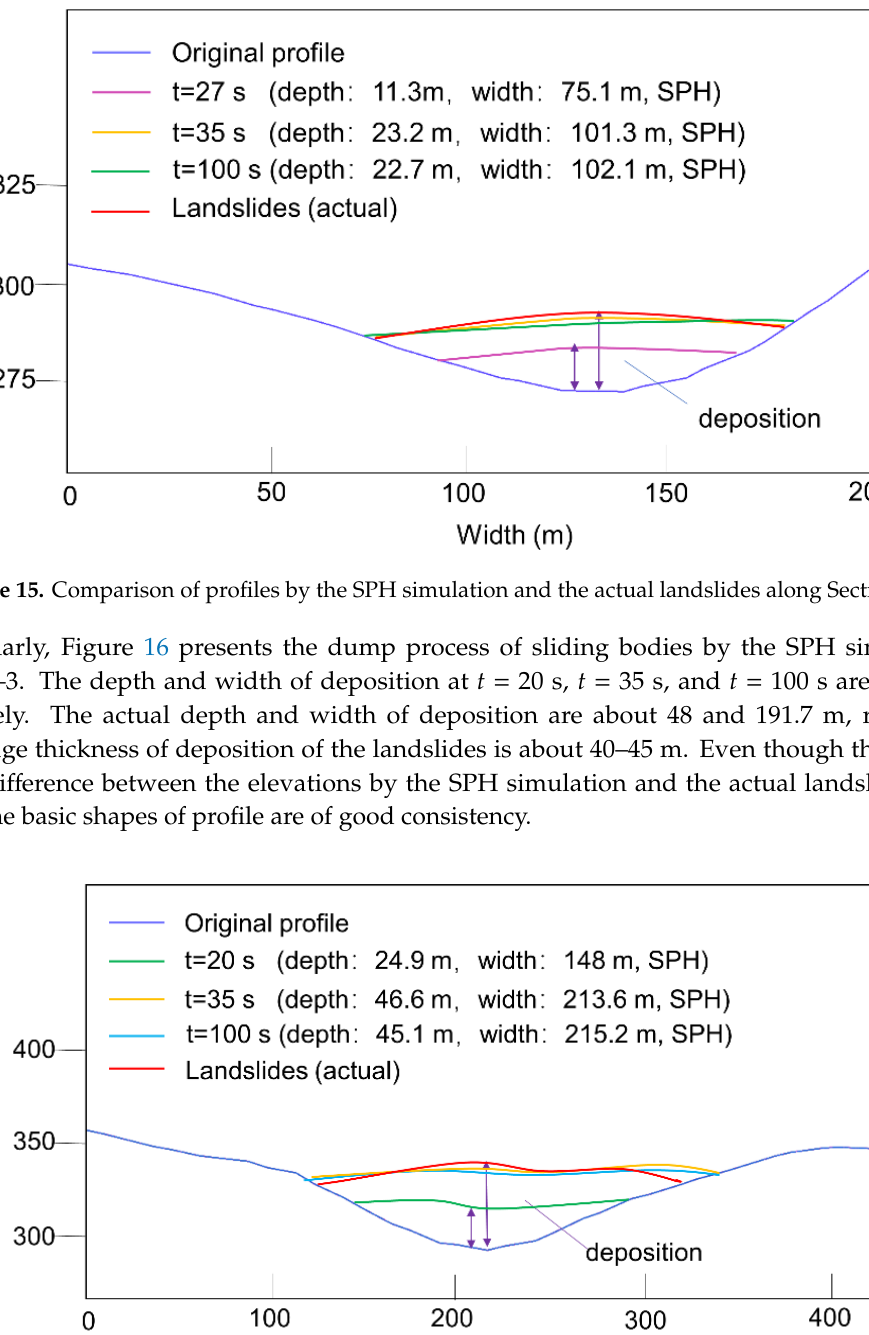
Figure 14. Comparison of profiles by the SPH simulation and the actual landslides along Section 1–1.